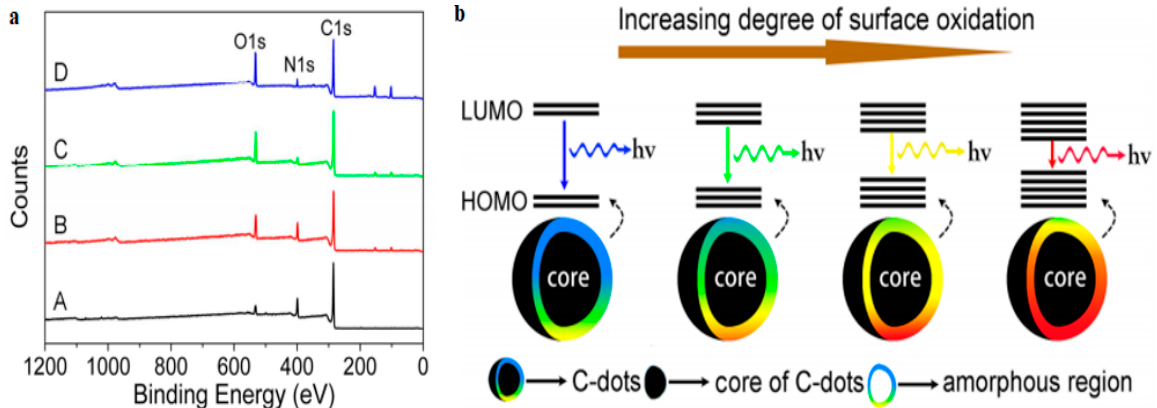
Figure 6. ( a ) XPS spectra of the fractions A, B, C and D. ( b ) Effect of the surface oxidation degree on the PL properties of C-dots (as the energy gap gets narrower, the photons’ frequency decreases). Reprinted (adapted) with permission from [60]. Copyright 2021 American Chemical Society.